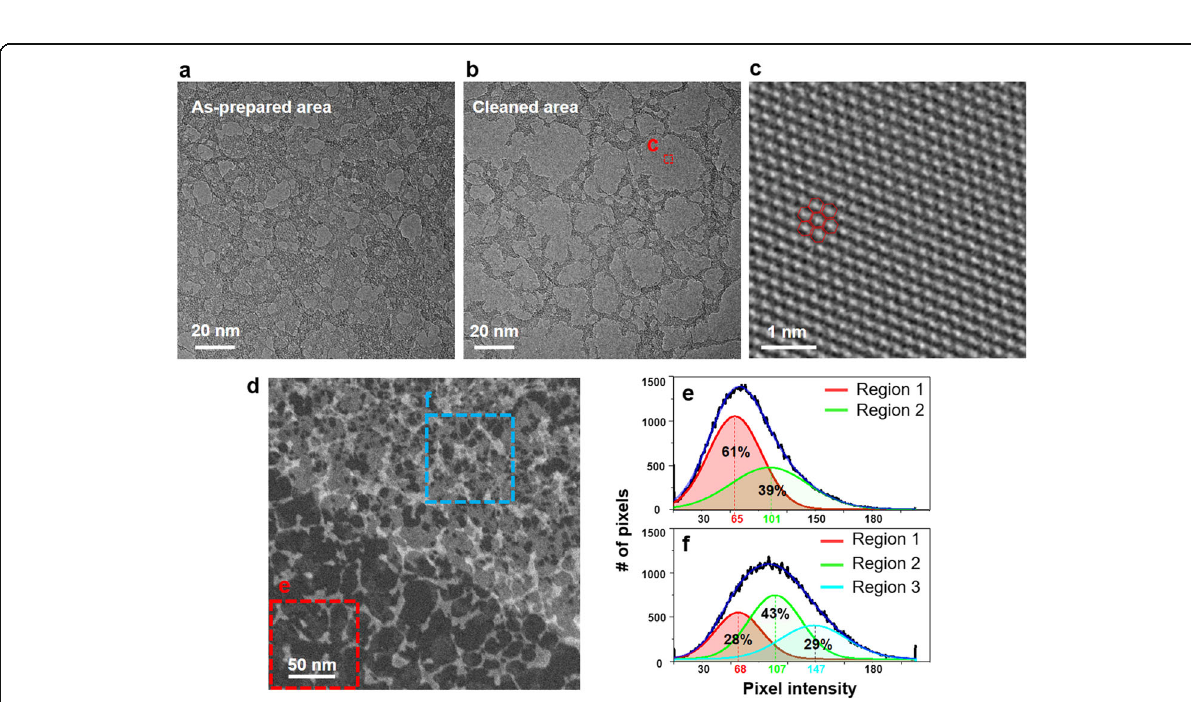
Fig. 4 Residue coverage comparison between the as-prepared and mechanically cleaned area. a TEM image of the as-prepared graphene region. b TEM image of the mechanically cleaned graphene region. The red box is the field of view of panel ( c ). c Close-up TEM image showing the pristine graphene lattice without surface residue. The marked red hexagons represent the honeycomb lattice of graphene. d HAADF-STEM image of the partially cleaned graphene sample. The dark bottom region is from the mechanically cleaned region. The images in the dashed two boxes were used for the intensity analysis shown in panels ( e ) and ( f ). e Histogram of the pixel intensities shown in box e. The two peaks from relatively high- and low-intensity regions were deconvoluted from the histogram. f Histogram of the pixel intensities shown in box f. The three sub-peaks were deconvoluted from the